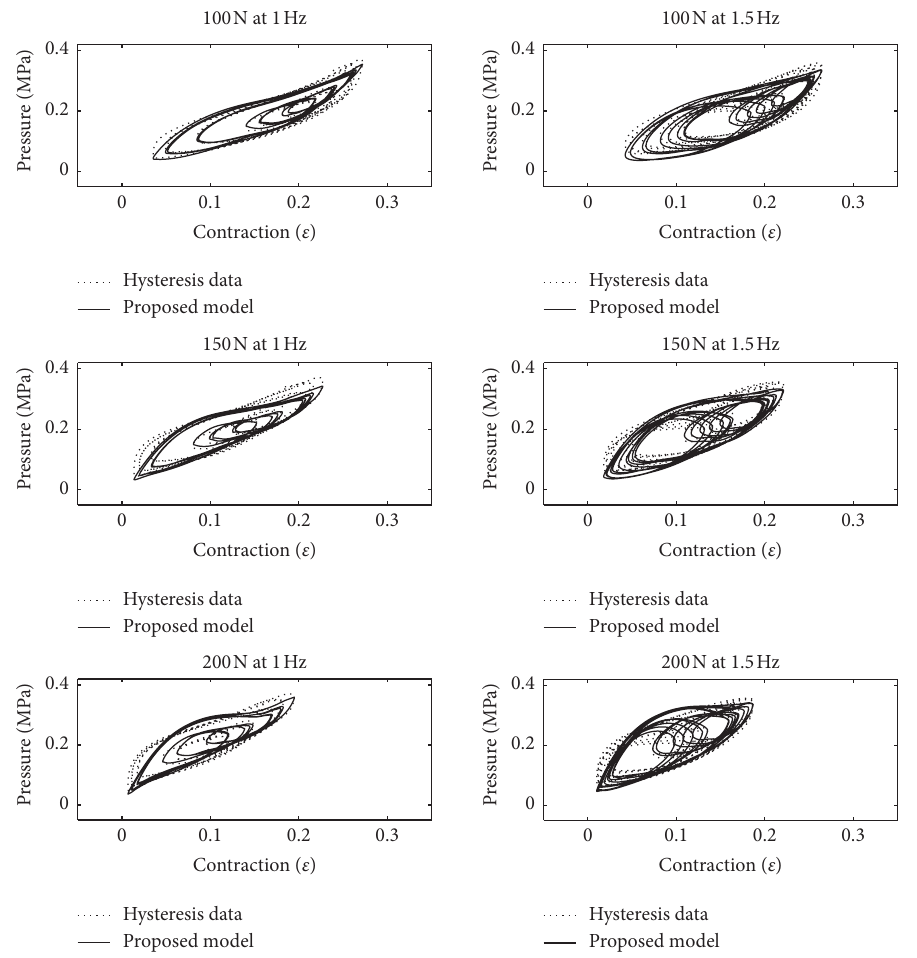
Figure 12: Sample of hysteresis simulation at evaluated frequencies and external